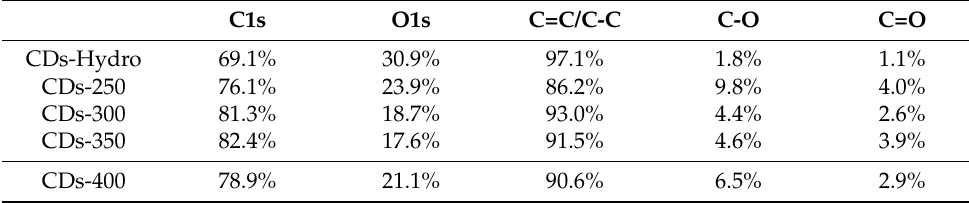
Figure 6. ( a ) XPS survey spectra, and ( b ) high-resolution C1s spectra of CDs-Hydro and CDs-250-400.